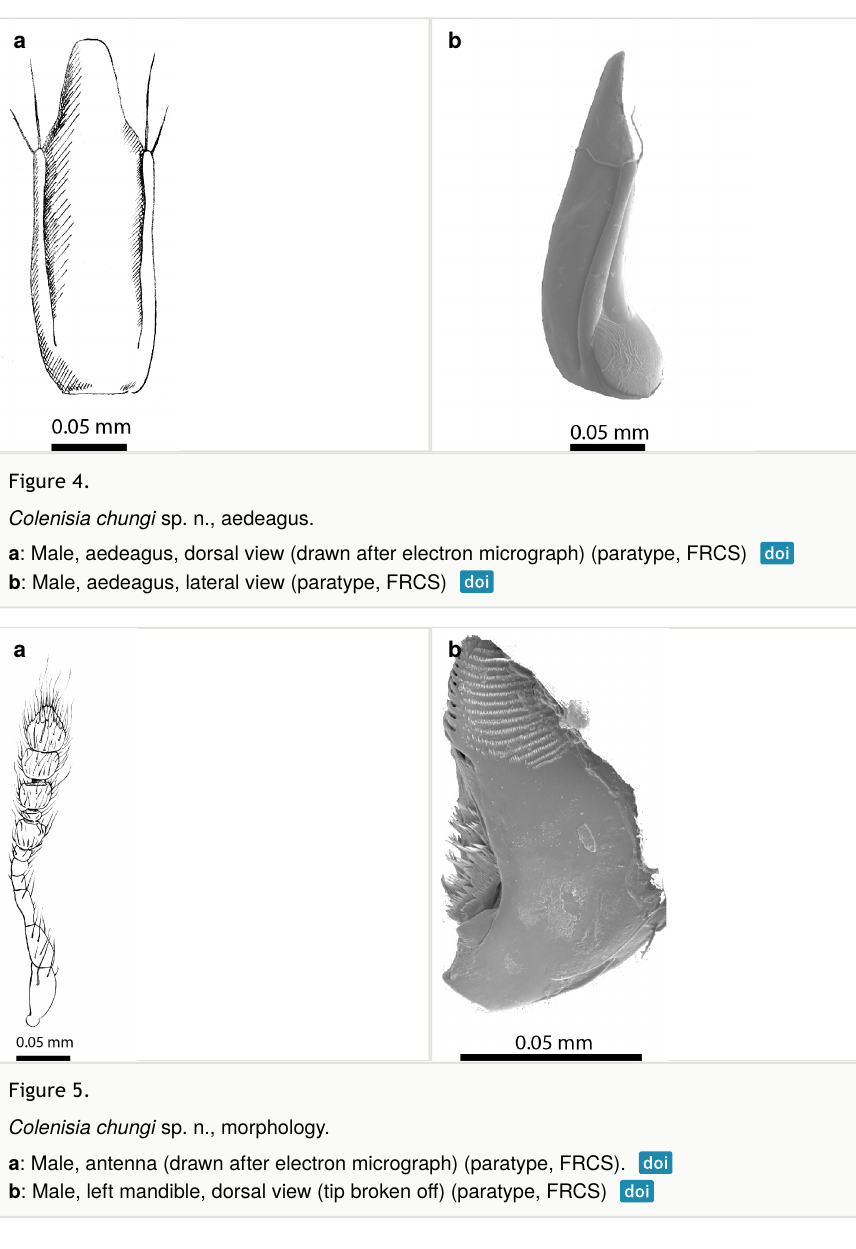
diameter, bearing short, inconspicuous hairs. Scutellum : Microsculptured as on pronotum.